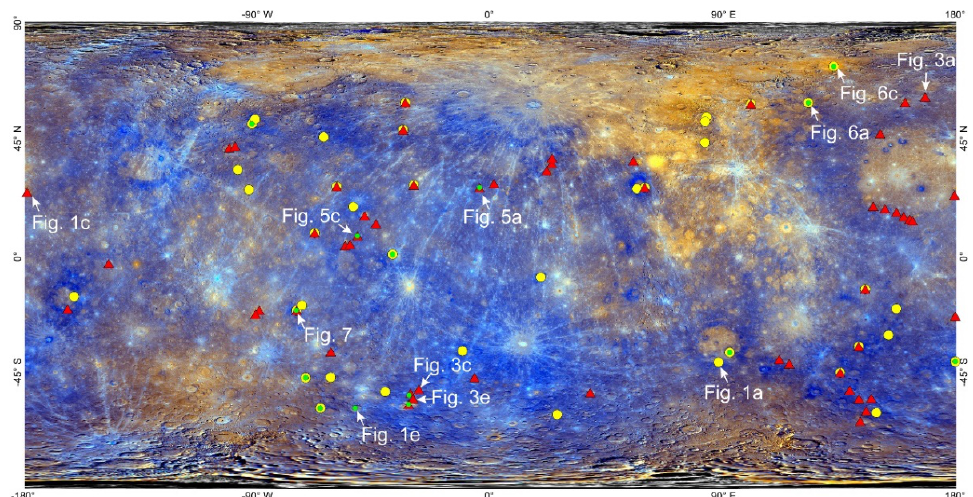
Figure 2. Distribution of pitted-ground terrains defined in this study and confirmed as volcanoes, listed by Thomas et al. (2014) [6,10] and Jozwiak et al. (2018) [11]. Yellow spots are those cataloged by Thomas et al. (2014) [6,10]. Red triangles are irregular pitted terrains cataloged by Jozwiak et al. (2018) [11]. Green spots are pitted-ground volcanoes defined in this work. White arrows show locations of cases reported in this study. IDs of the base data used are listed in Table S1. Table 1. Information of pitted-ground terrains that are interpreted as pyroclastic vents in this study. Longitude ( ◦ ) Latitude ( ◦ ) Location